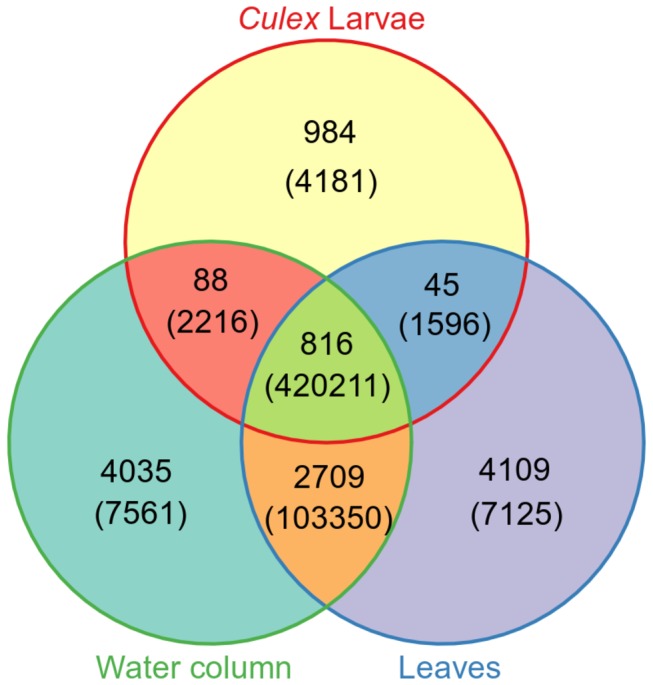
Overlap of bacterial communities across habitats.Venn diagram illustrating overlapping of Bacteria OTUs and sequences between mosquito larvae and habitat (

C

. tarsalis
 larvae; habitat = leaves of alkali and California bulrushes; water = water column samples). The first number represents the number of OTUs, while the number in parentheses represents the number of sequences.